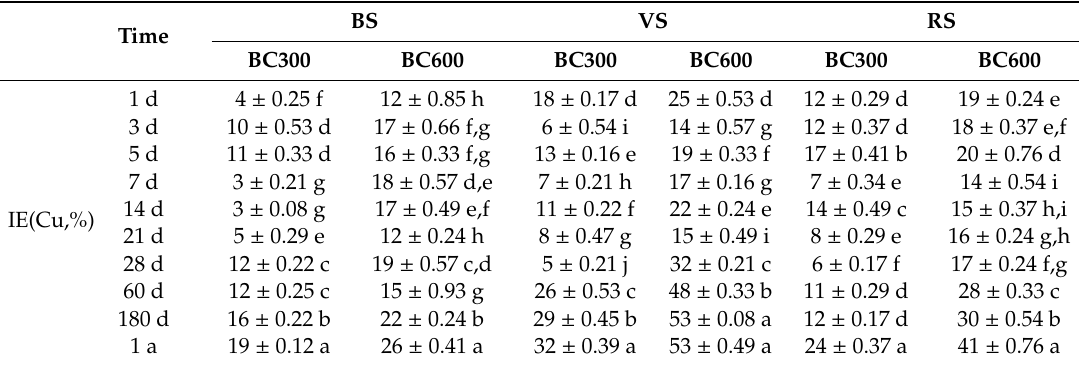
Table 2. The immobilization e ff ectiveness (IE) of Cu in three amended soils with biochars (BCs). Values are the mean ± standard deviations, and the di ff erent letters in the same column represent that significant di ff erence at p < 0.05 ( n = 3, LSD